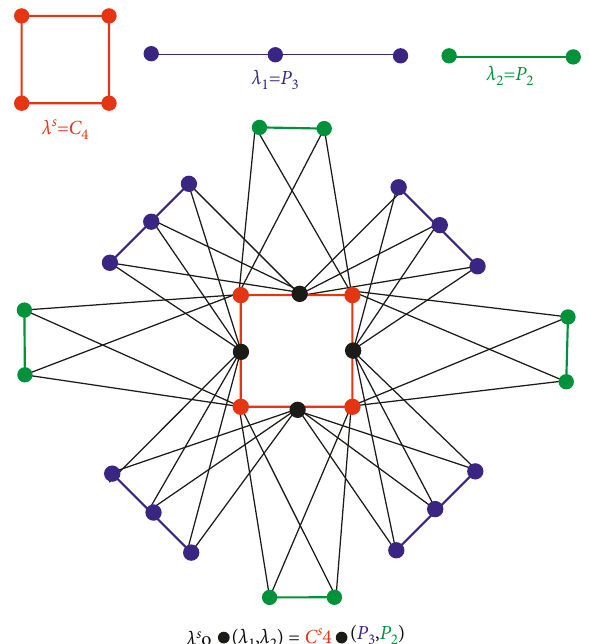
Figure 2: Subdivision double neighborhood corona product · ( P , P )) ( C s 3 2 4